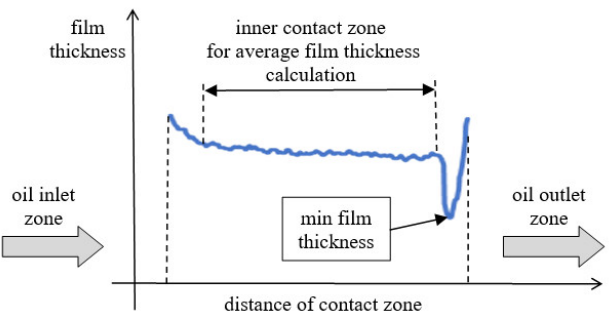
Figure 8. Scheme of the oil film thickness distribution in the non-conformal sliding contact in parallel to the direction of disc rotation.